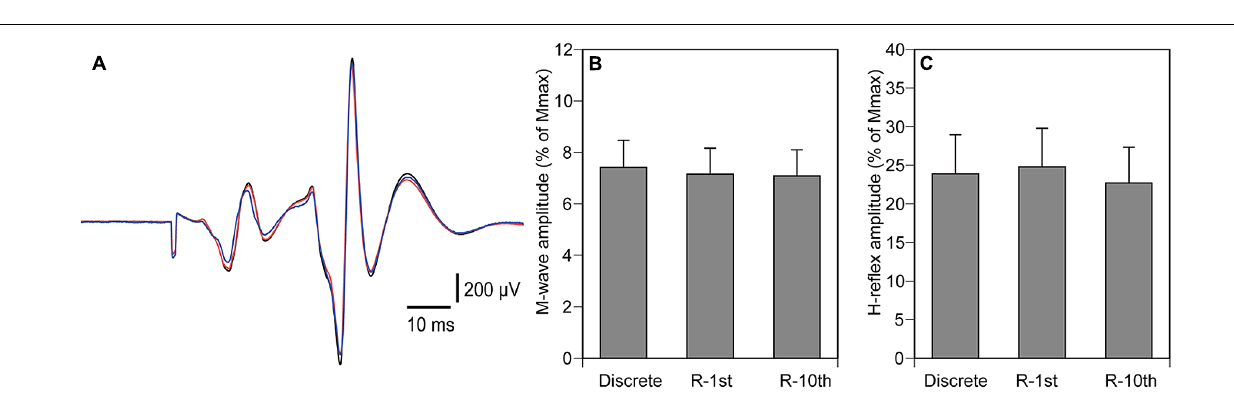
blue trace indicates H-reflex in the R-10th condition (A) . Note that the amplitudes of the H-reflex are similar for all conditions. Bars indicate mean and error bars indicate standard error of mean (B,C)